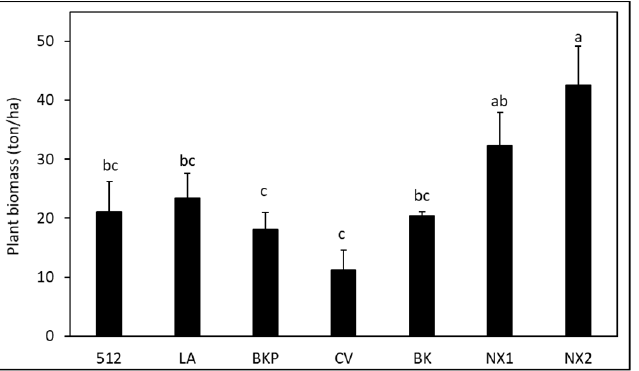
Figure 3. Biomass of SSgH generated from 512 (512 × 14), LA (Latte), BKP (Big Kahuna Plus BMR),